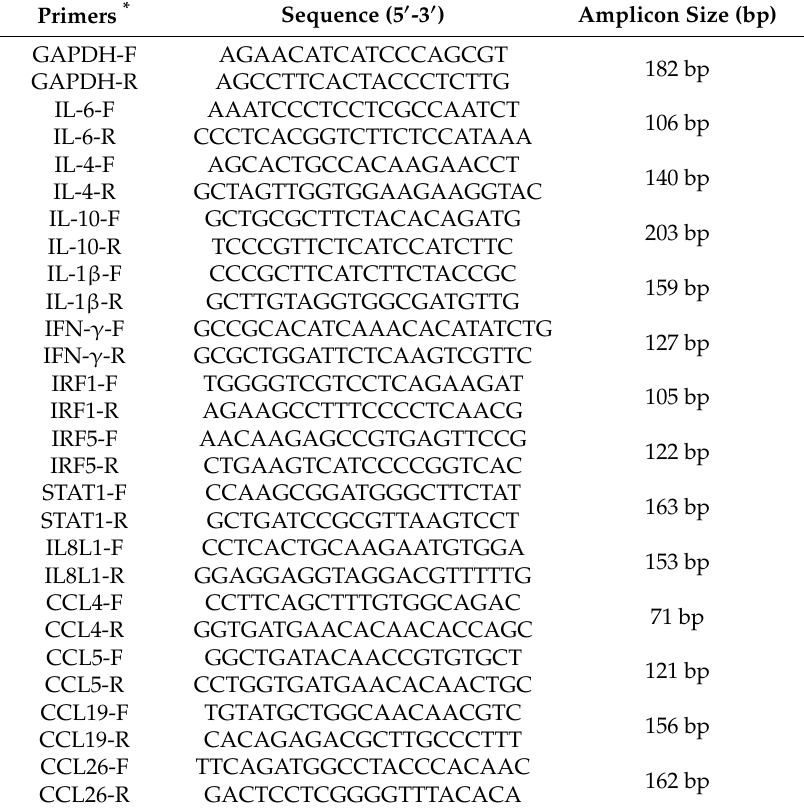
Table 1. List of primers used in this